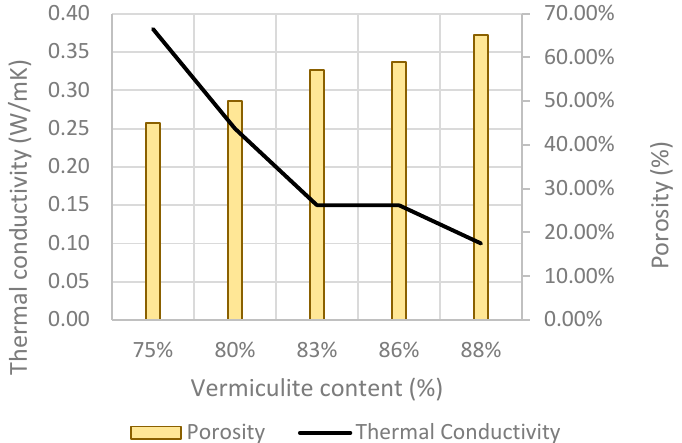
Figure 18. Correlation of vermiculite content, thermal conductivity, and porosity from the study by Koksal et al. (2020) [56].